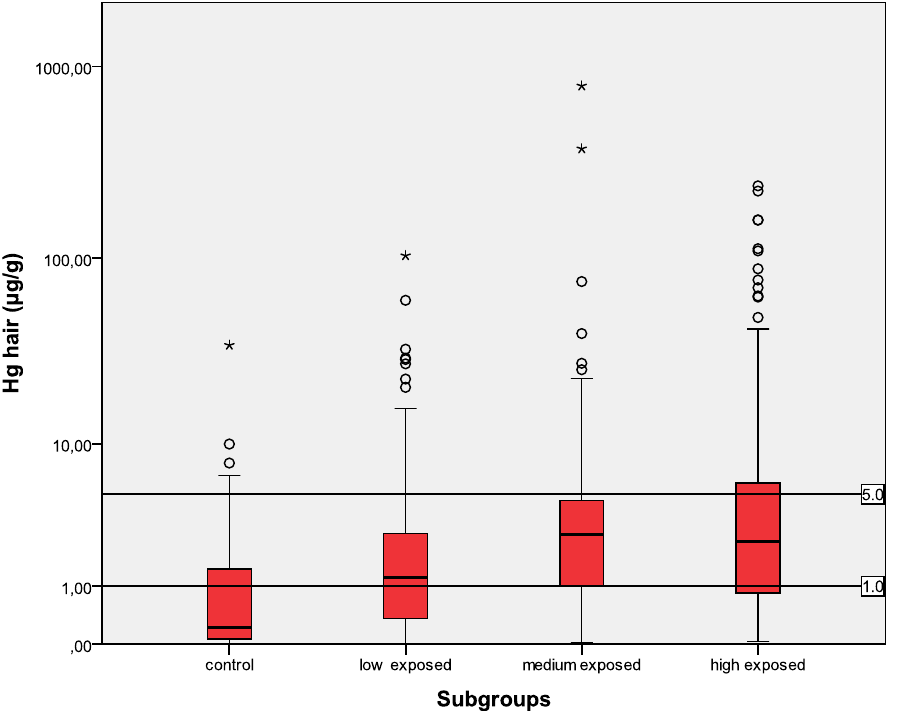
Figure 4. Hair mercury concentrations in four exposure groups (comparison lines 1.0 µg/g and 5.0